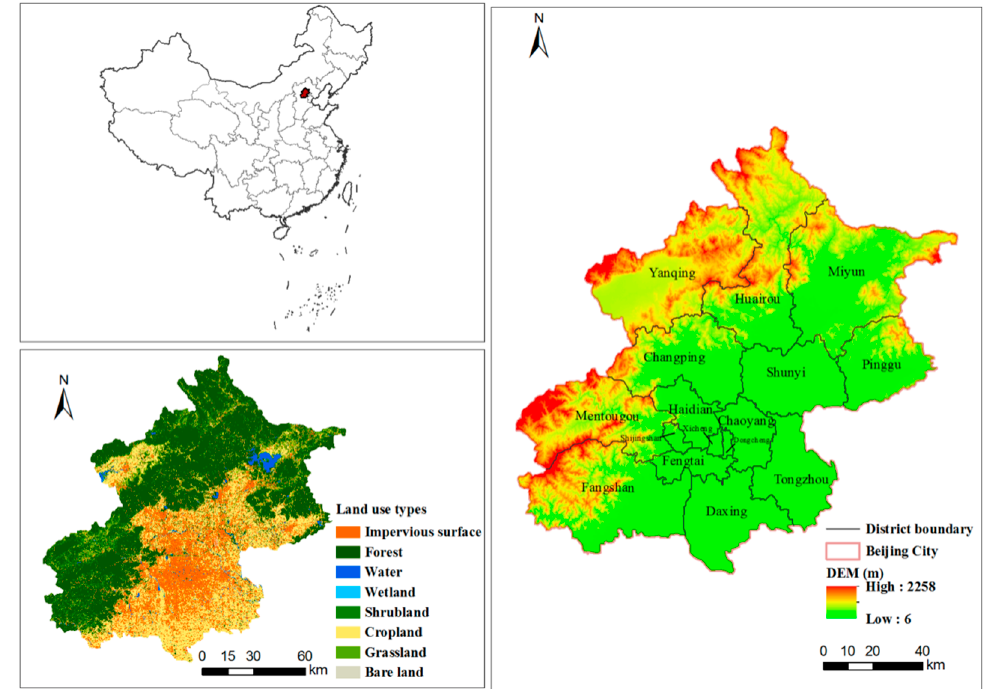
Figure 2. Location of Beijing.